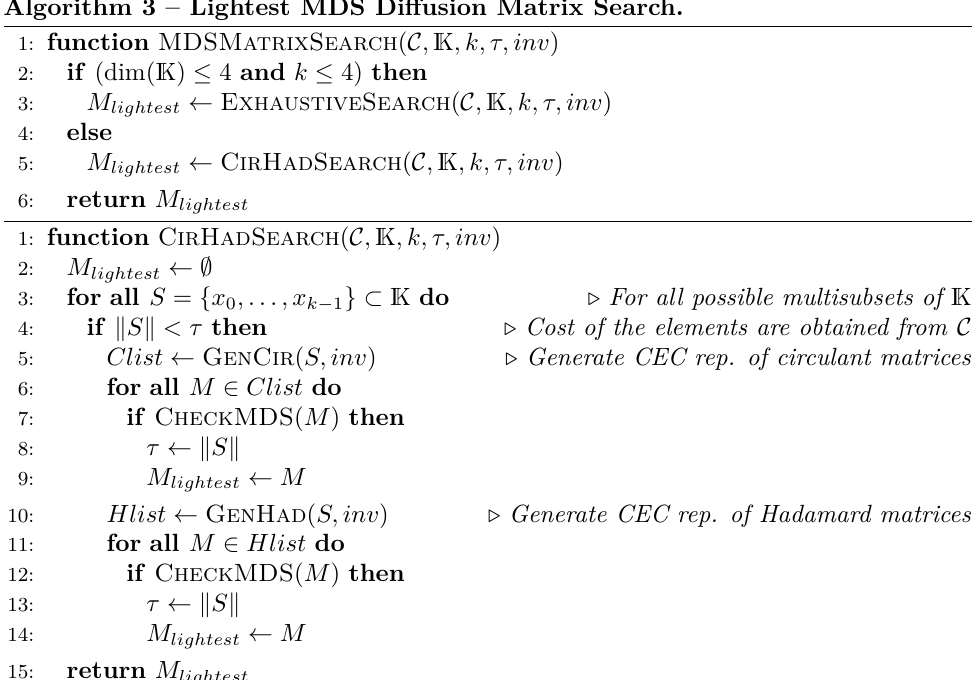
Algorithm 3 – Lightest MDS Diffusion Matrix